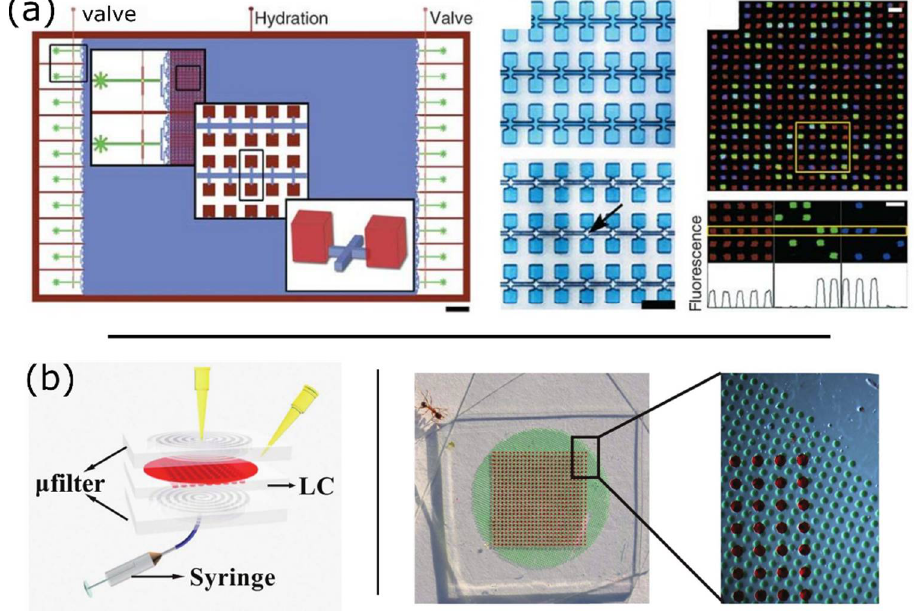
Figure 7. Passive partitioning platforms. ( a ) Megapixel digital PCR using planar emulsion arrays. Left panel : Schematic of the megapixel digital PCR device, with insets showing the array and chambers at increasing magnification. Scale bar: 3 mm. Central panel: The chambers are loaded with a blue dye. The arrow indicates chambers isolated by immiscible oil . Scale bar: 50 μm. Right panel: Multiplexed detection of HLCS (green) and RPPH1 (blue) over 342 chambers. (top). A close-up view shows the signals of the boxed chambers in the different fluorescence channels (middle), with the corresponding intensity profile of the middle row (bottom) . Scale bars: 50 μm. (Figure adapted from [37] with permission.); ( b ) Vacuum-assisted reagent loading in a PDMS-based array of microwells. Left panel: The schematic of the microfluidic chip depicts the process of reagent loading into the lamina chip layer via a filter layer. The syringe is used to create a temporary vacuum through the PDMS layer and drive liquid into the microwells. Right panel: Device loaded with the reagent (red) and water (blue). (Figure adapted from [72] with permission.)